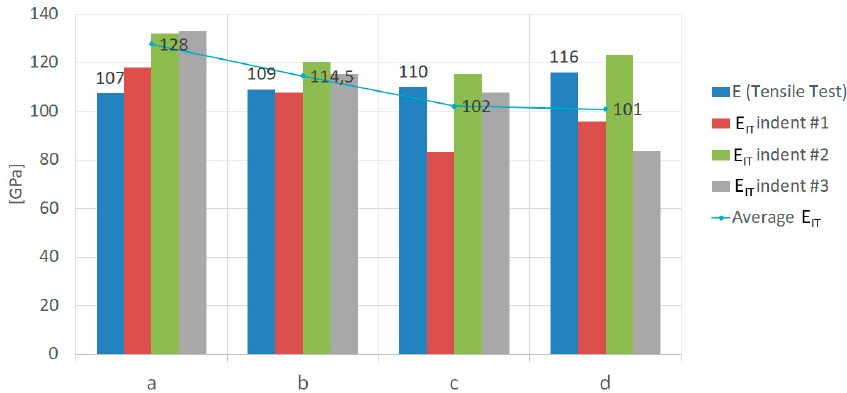
Figure 15. Comparison between Young modulus ( E ) and mean indentation modulus ( E IT ) for three indents (300 N); average E IT (baseline) has been computed as an average over the three indents.